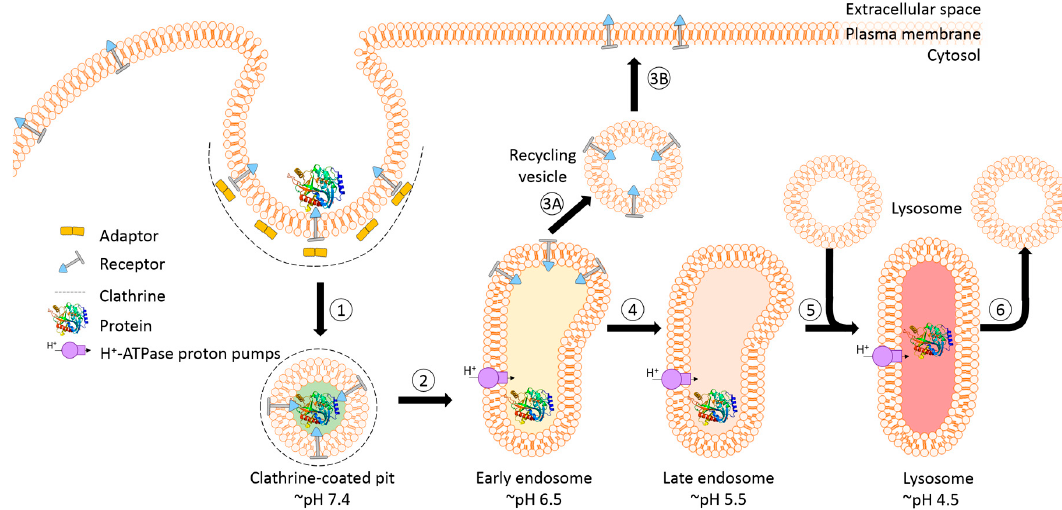
Figure 4. Schematic representation of receptor-mediated endocytic uptake of tumor-targeted proteins.